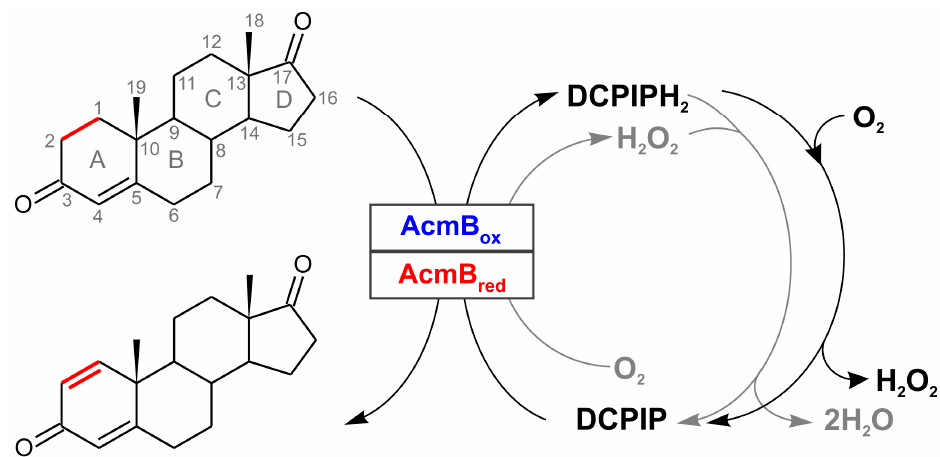
Figure Figure 1. The schematic representation of reaction catalyzed by AcmB: Dehydrogenation of 4 ‐ androstene ‐ 3,17 ‐ dione to 1,4 ‐ androstadiene ‐ 3,17 ‐ dione and reoxidation of the enzyme by DCPIP or O 2 as well as the reoxidation of DCPIPH 2 by H 2 O 2 formed in situ or O 2 .